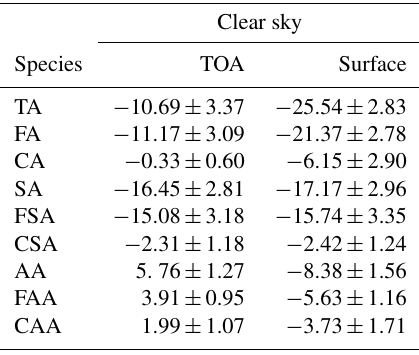
Table 3. The annual mean aerosol direct radiative forcing (Wm − 2 ) in the urban area of Nanjing.